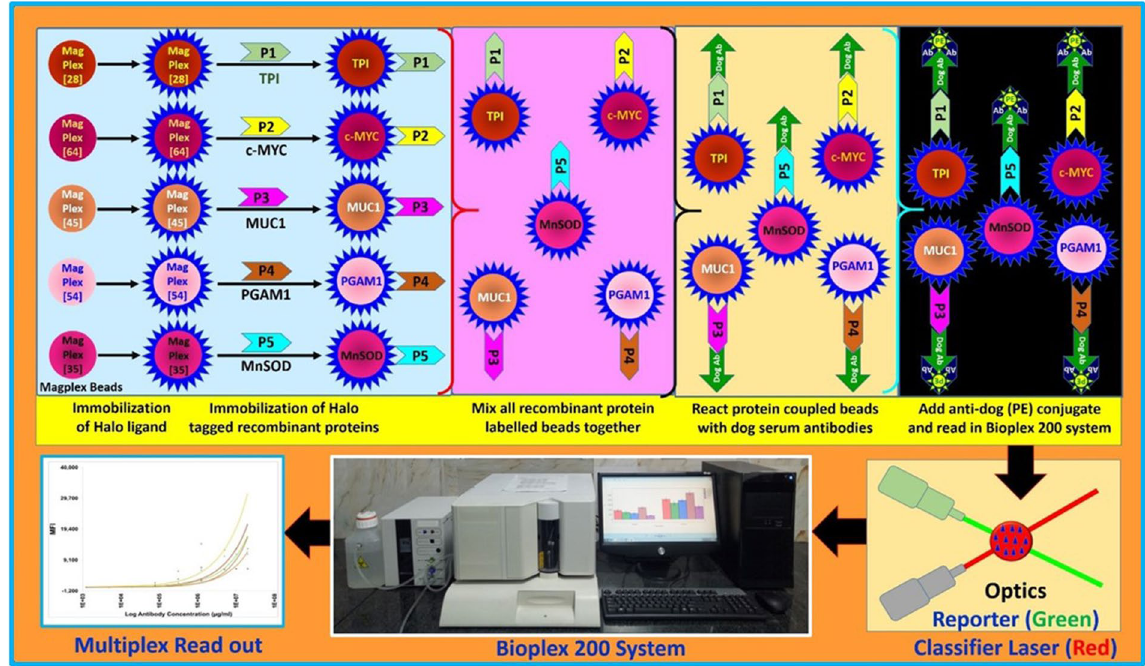
Figure 2. Schematic representation of strategy for developing multiplex immunoassay for detecting autoantibody biomarkers in dog sera